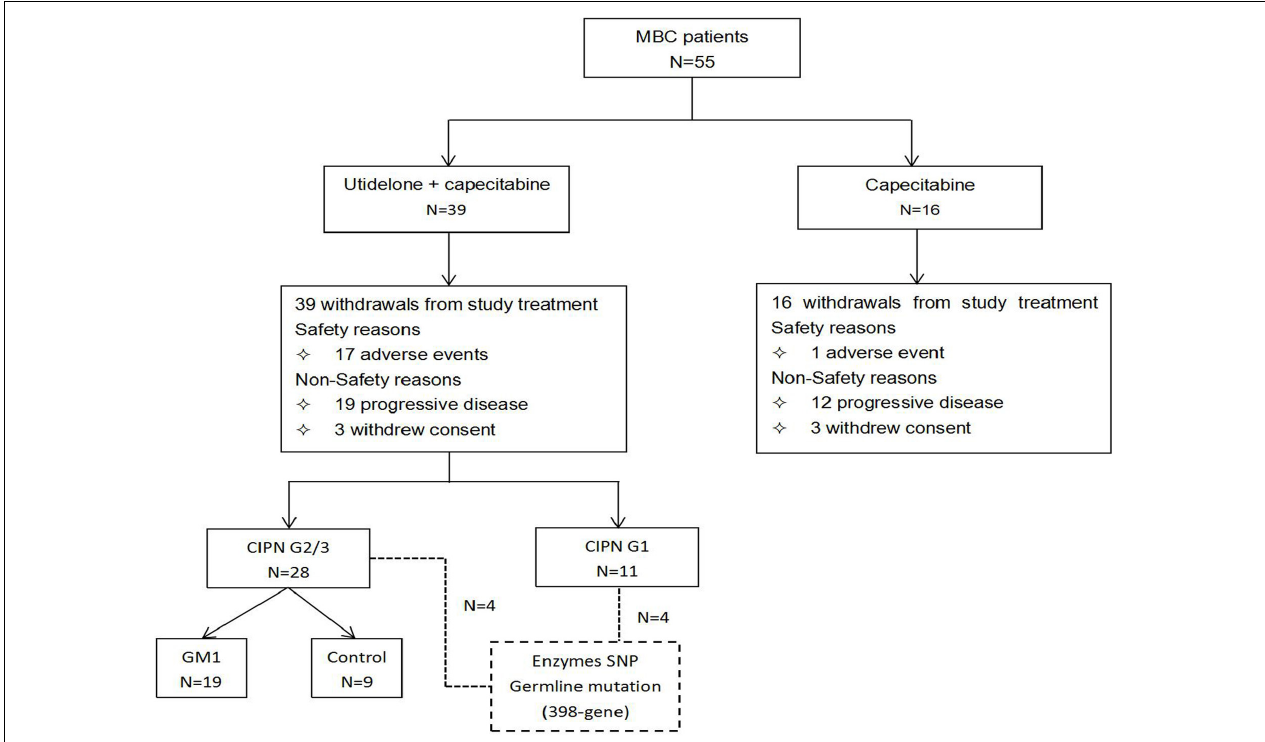
FIGURE 1 | Patient disposition in our center population in the BG01-1323L study. Flow diagram showing patient enrollment, allocation, follow-up, and analysis in our center population from the BG01-1323L